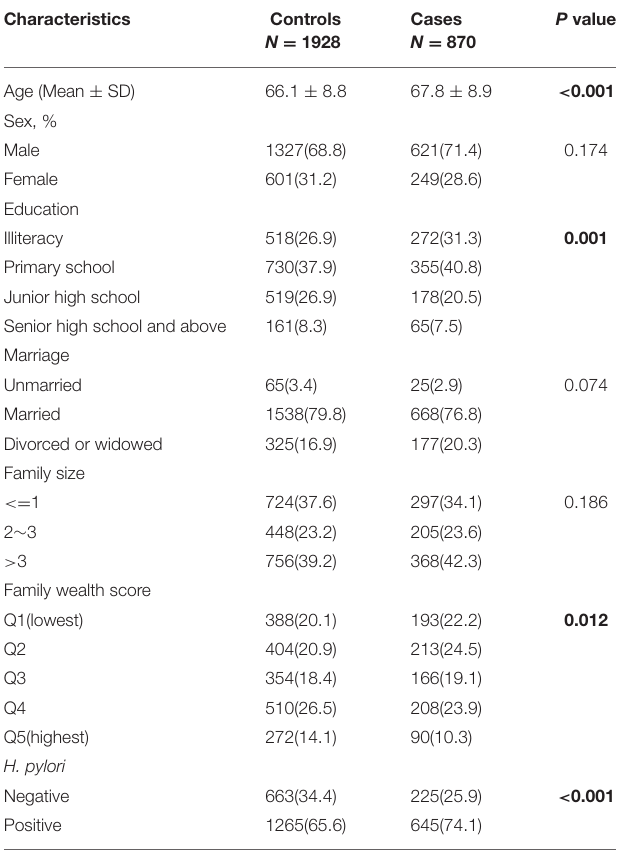
TABLE 1 | The basic information of cases and